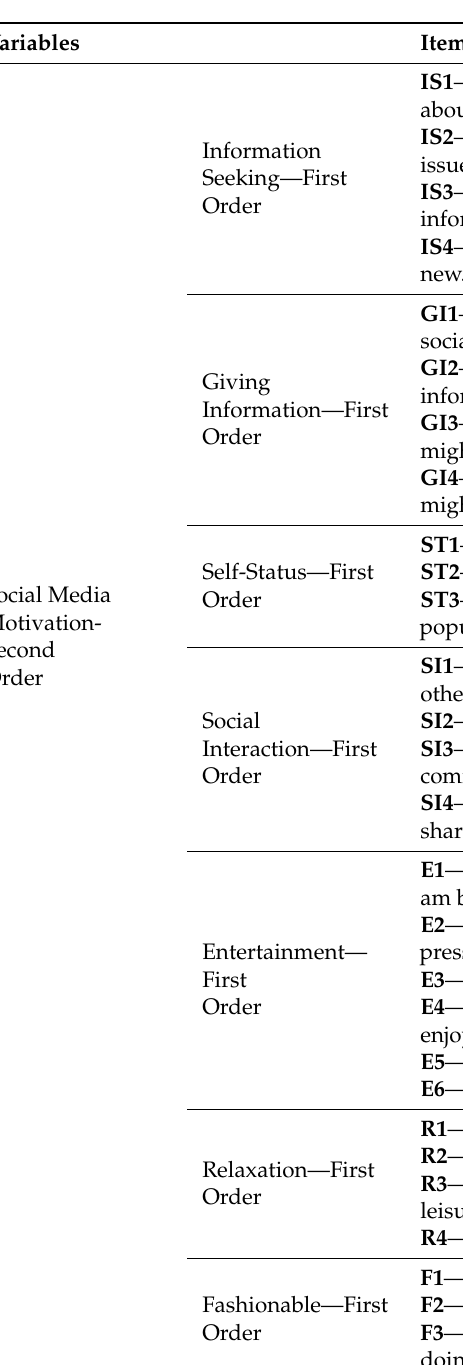
Table 1. Measurements scale, construct reliability, and validity: composite reliability (CR) and average variance extracted